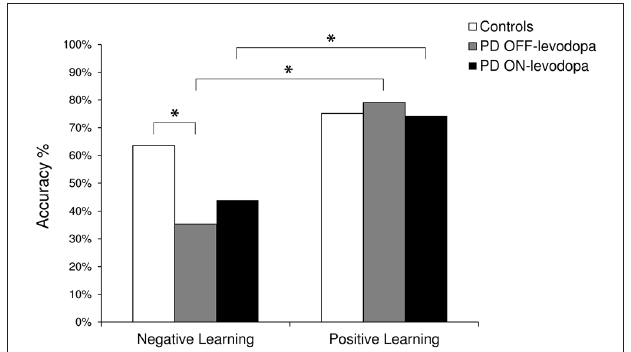
FIGURE 2 | Grand-average of response-locked event-related potentials (ERPs) to error and correct trials in (A) controls, (B) PD patients ON-levodopa and (C) PD patients OFF-levodopa at Cz. PD, Parkinson’s